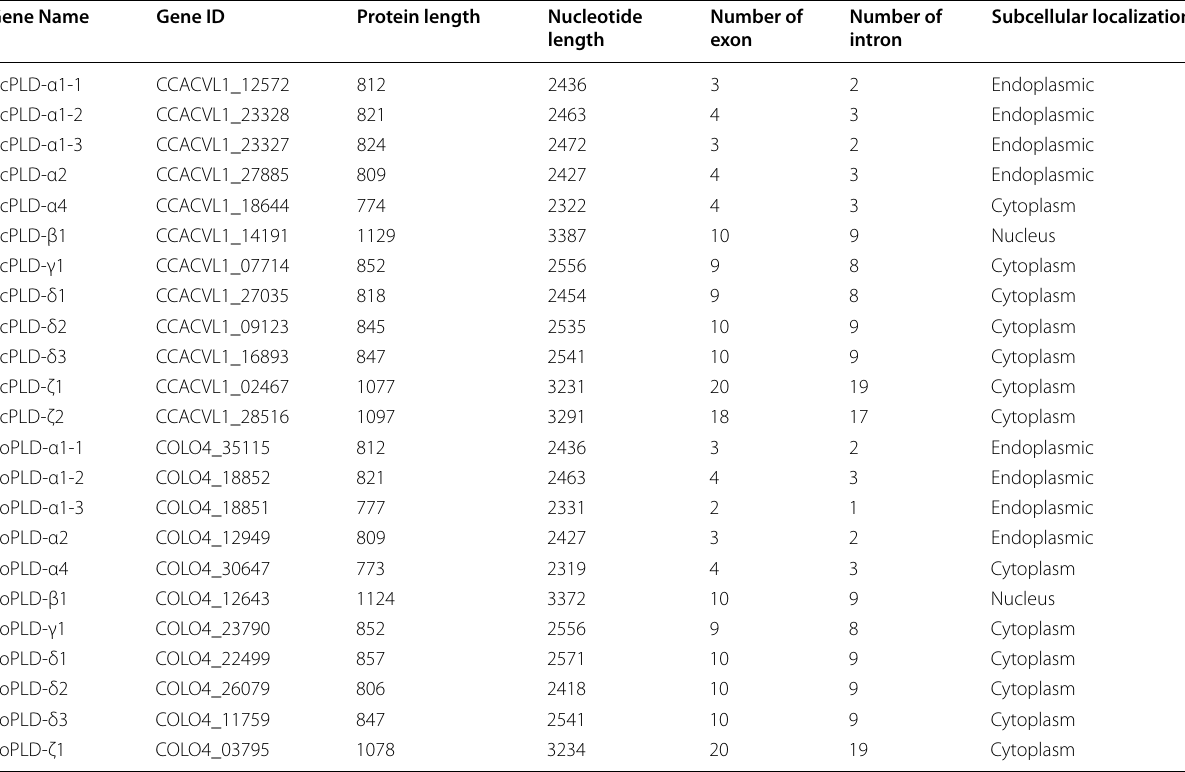
Table 1 Basic information of identified PLD genes of C . capsularis and C .